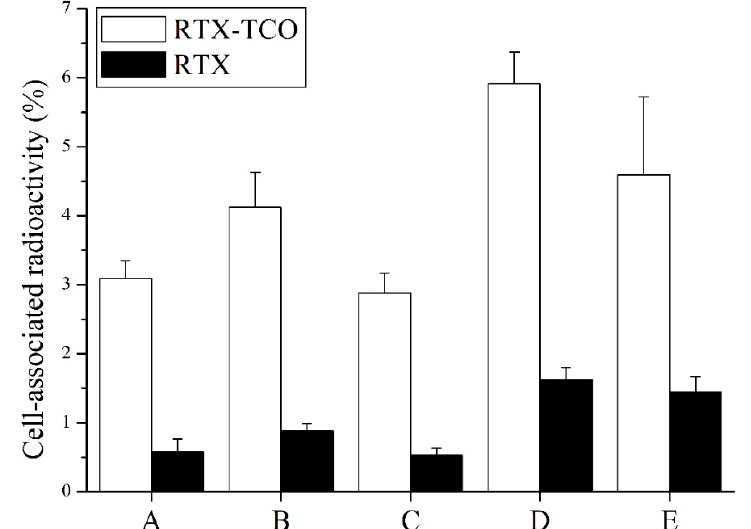
Figure 2. Cell binding studies of [ 68 Ga]Ga-SulfoCy5-MAFC-PEG 5 -Tz (A), [ 68 Ga]Ga-SulfoCy7-MAFC- PEG 5 -Tz (B), [ 68 Ga]Ga-IRDye800CW-MAFC-PEG 5 -Tz (C), [ 68 Ga]Ga-SulfoCy5-FSC-(PEG 5 -Tz) 2 (D), and [ 68 Ga]Ga-IRDye800CW-FSC-(PEG 5 -Tz) 2 (E) on CD20-expressing Raji cells pre-treated with trans -cyclooctene (TCO) modified rituximab (white bars) and non-modified antibody (black bars).